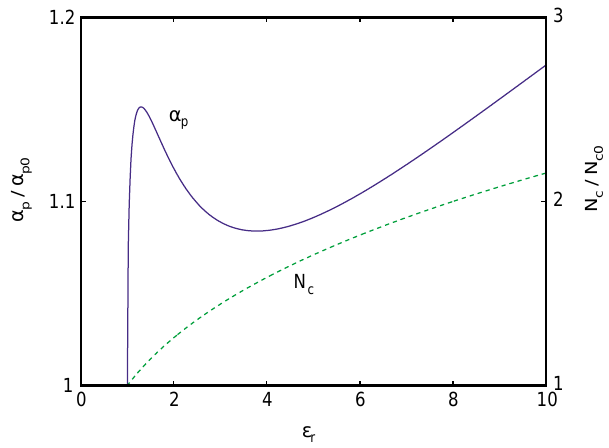
FIG. 8. (Color) Relative momentum compaction a p (cid:1) a p 0 and relative number of TME cells N c (cid:1) N c 0 plotted as a function of the “detuning” factor ´ r . The normalization of these relative curves is with respect to their values at ´ r (cid:1) 1 [i.e., a p 0 (cid:7) a p (cid:5) ´ r (cid:1) 1 (cid:6) and N c 0 (cid:7) N c (cid:5) ´ r (cid:1) 1 (cid:6)